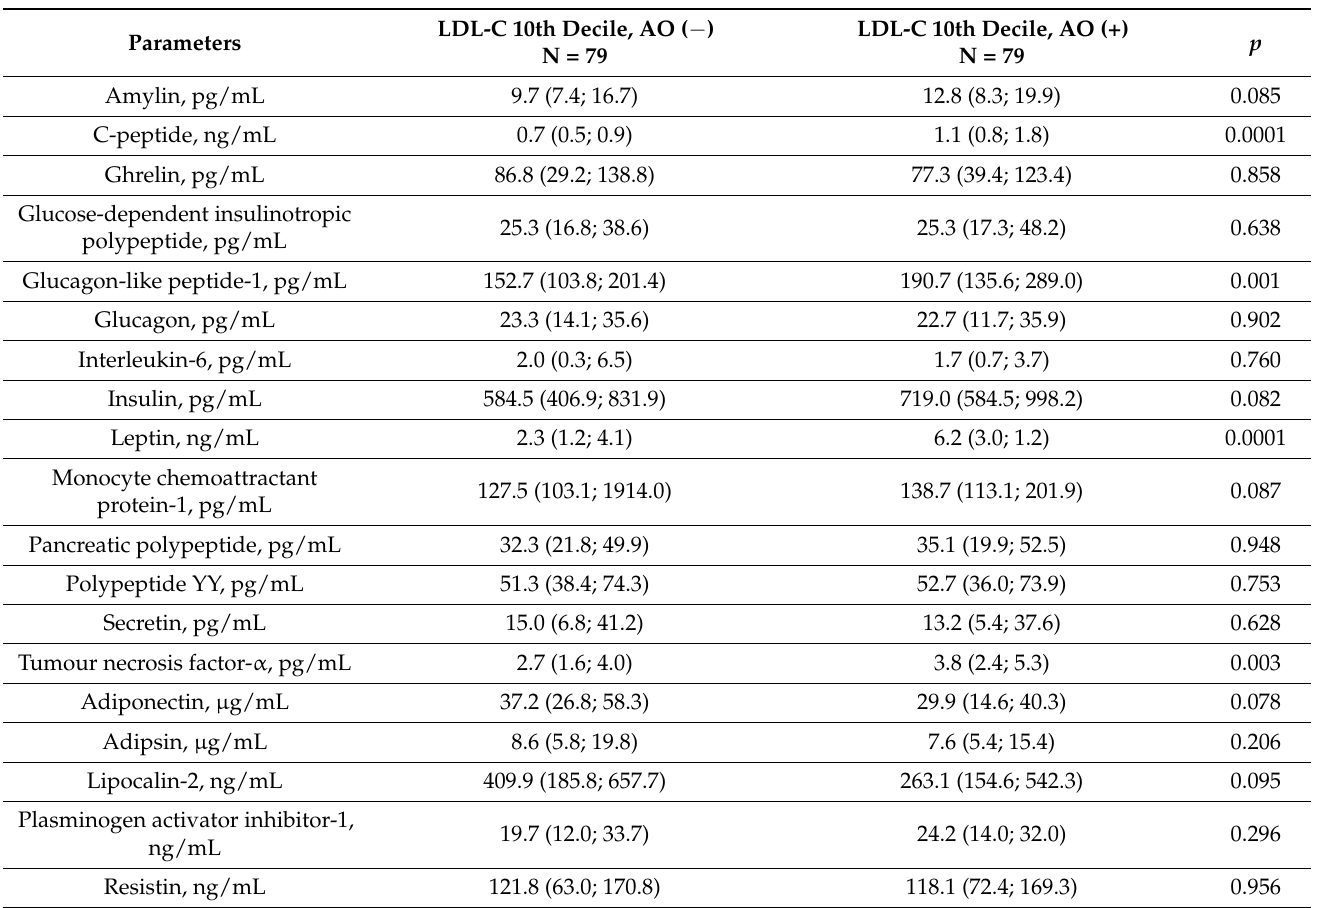
Table 1. Analysis of blood levels of adipokines/cytokines associated with the secretory activity of visceral adipocytes in people with hyper-LDL-C with and without AO (Me (25%;